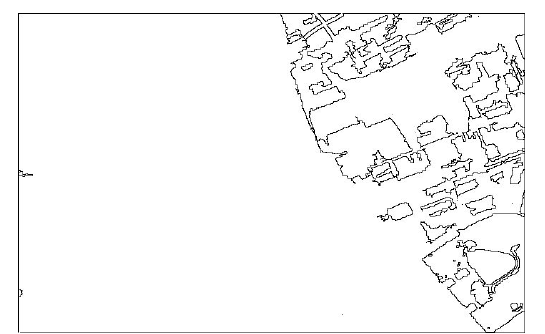
Table 2. Object repository